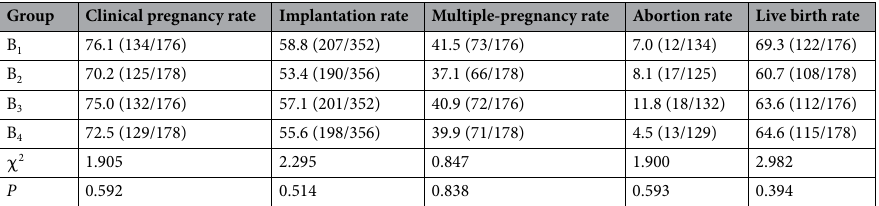
Table 4. Comparison of pregnancy outcomes between groups divided by serum estrogen levels on the blastocyst transfer day [% (n/n)].